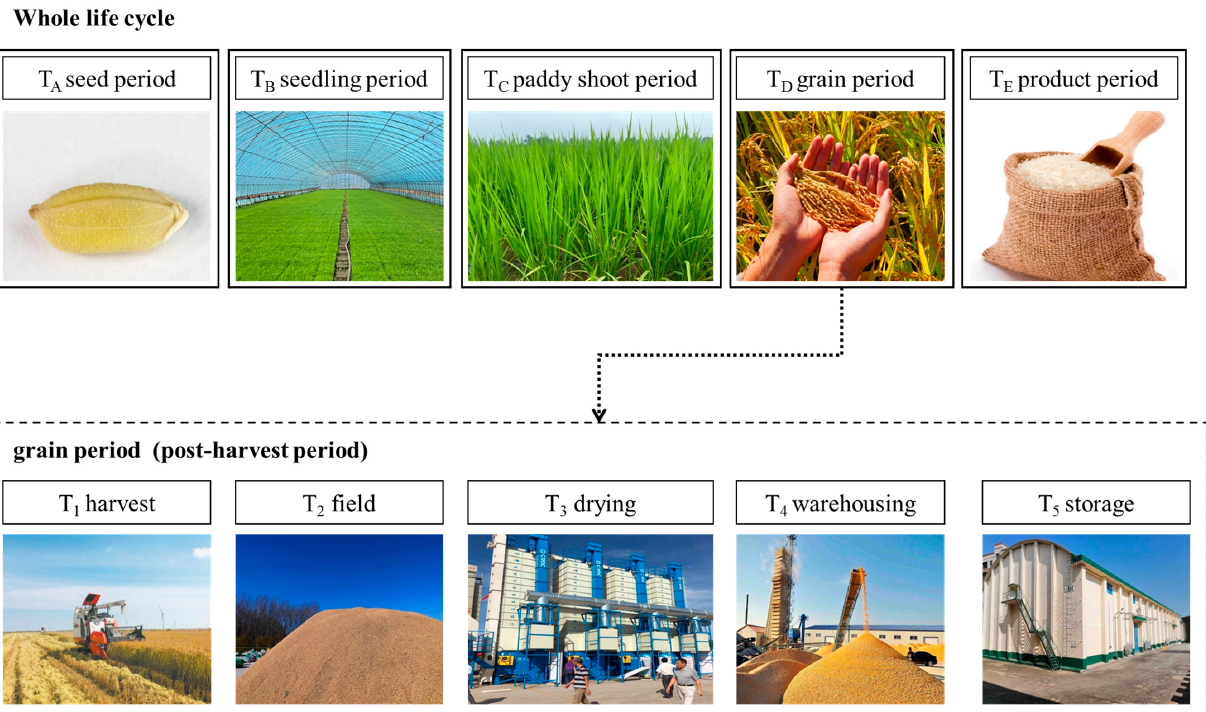
Figure 1. Division of the 5T rice management periods.